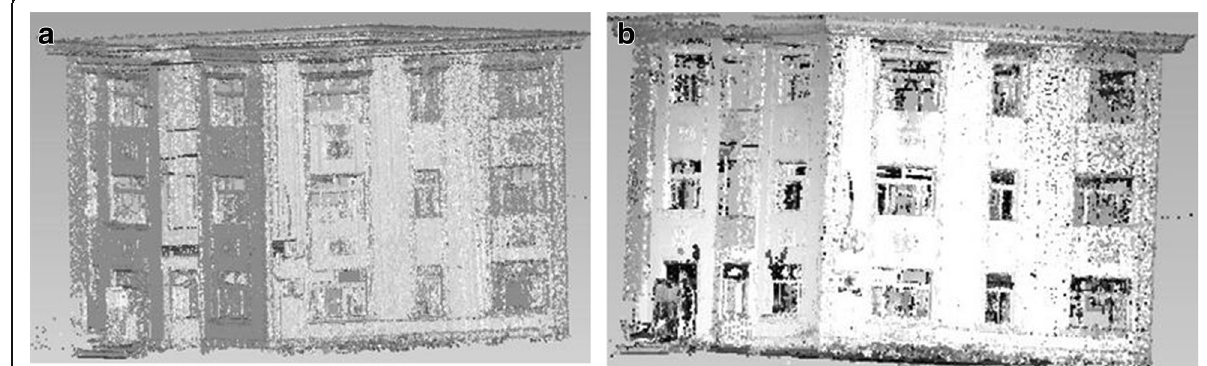
Fig. 10 Reconstruction of buildings. a Building 1. b Building